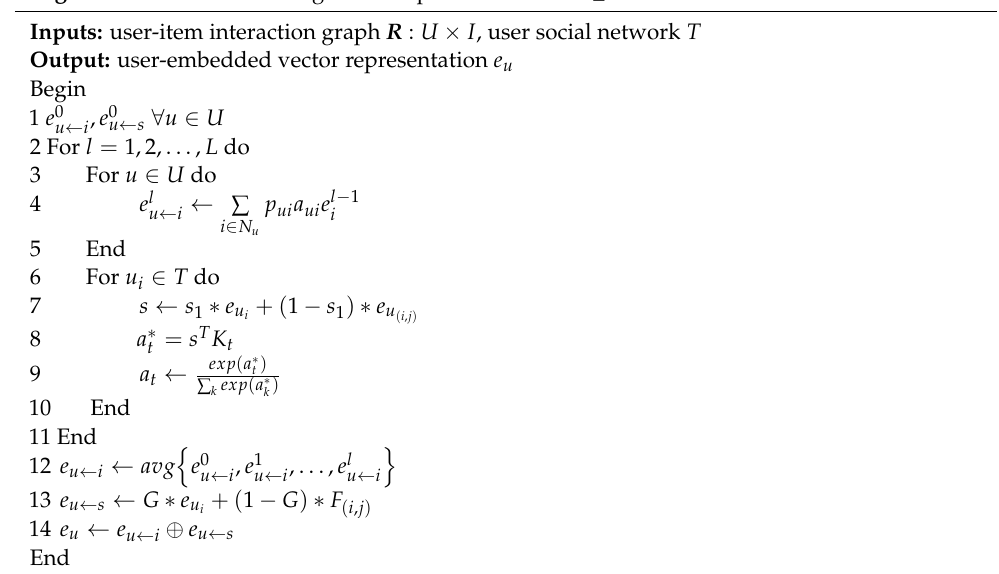
Algorithm 2 User embedding vector representation